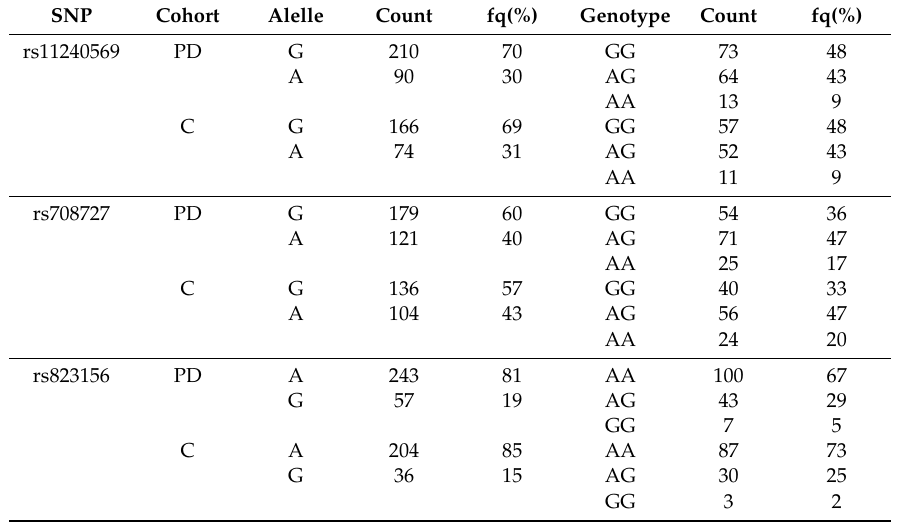
Table 1. Allele and genotype count and frequency in PD and control cohorts for tested A1 SNPs.